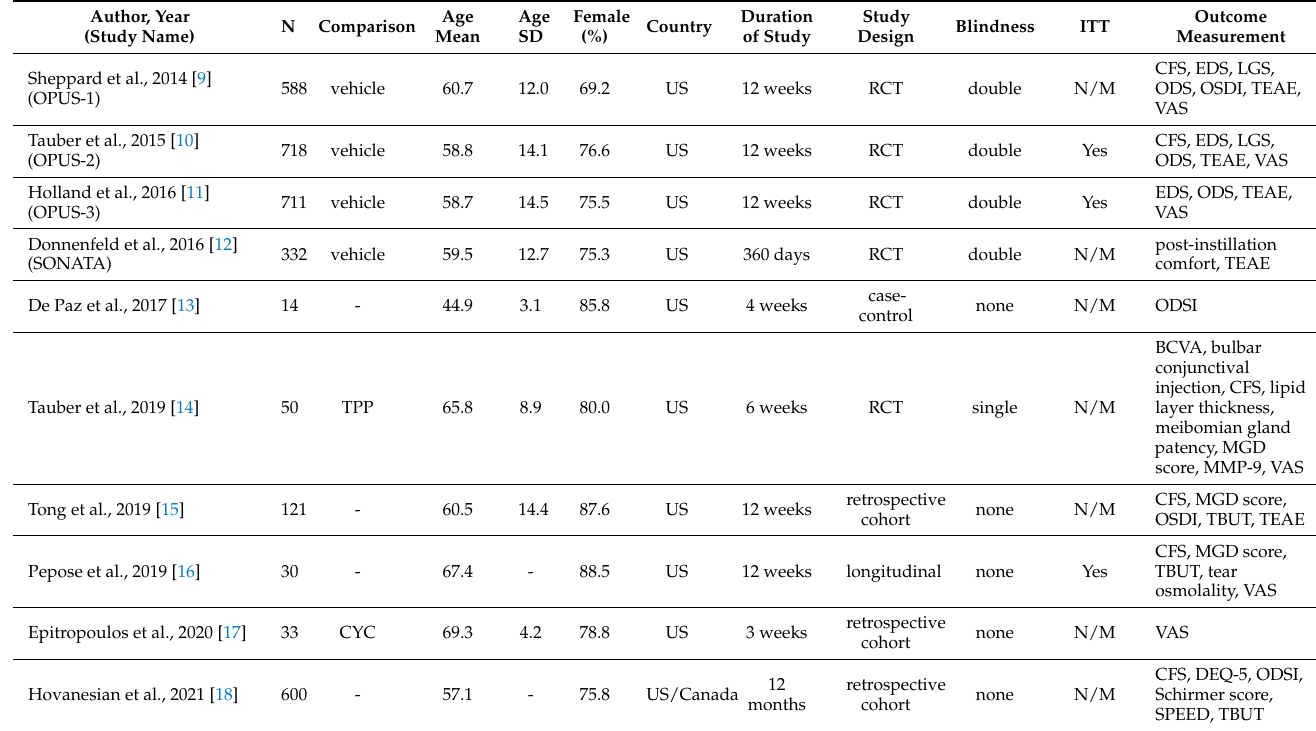
Figure 1. Flow diagram demonstrating the process of study identification. Table 1. Overview of included studies.